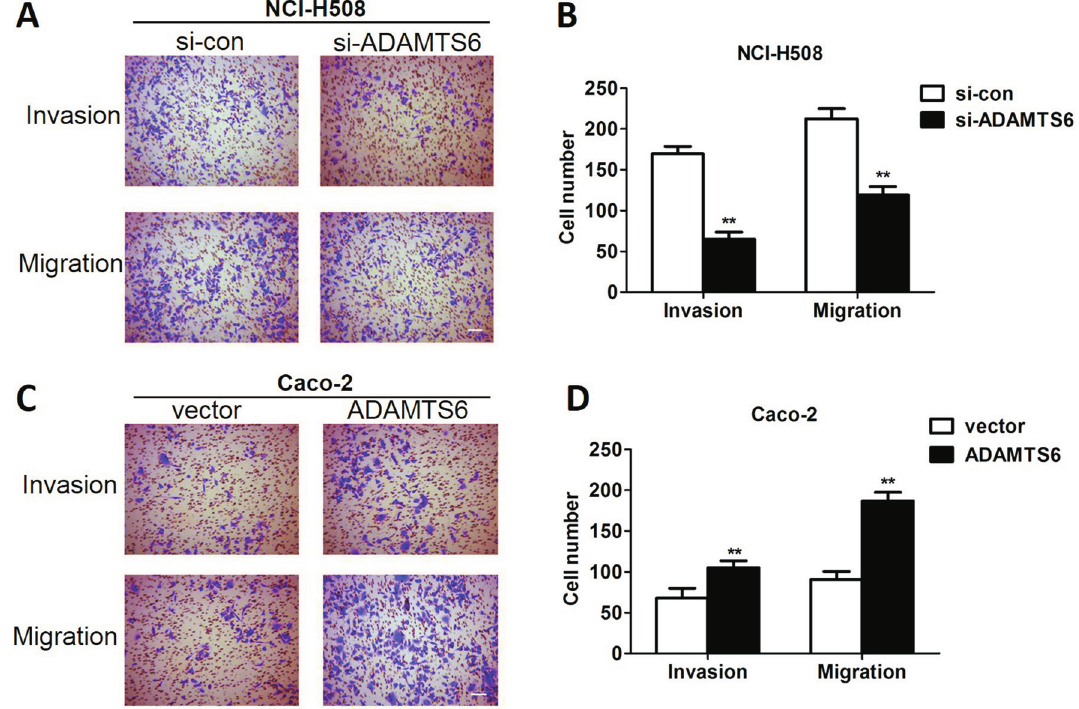
Figure4 -DepletionofADAMTS6suppressedtheinvasionandmigrationofNCI-H508cellsandADAMTS6overexpressionacceleratedCaco-2cellin- vasion and migration. (A) Bright field images of transwell assay in NCI-H508 cells were acquired by an inverted microscope (bar = 100 (cid:3) m). (B) Quanti- fication of (A). (C) Bright field images of transwell assay in Caco-2 cells were acquired by an inverted microscope (bar = 100 (cid:3) m). (D) Quantification of (C). **P <0.01 vs. si-control or vector